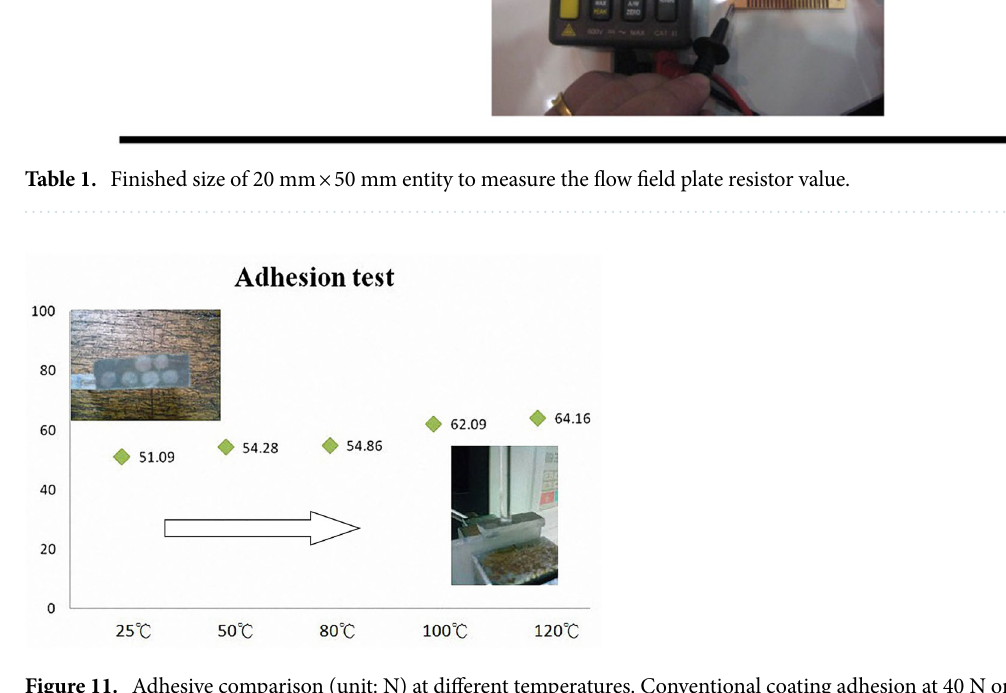
Figure 11. Adhesive comparison (unit: N) at different temperatures. Conventional coating adhesion at 40 N or